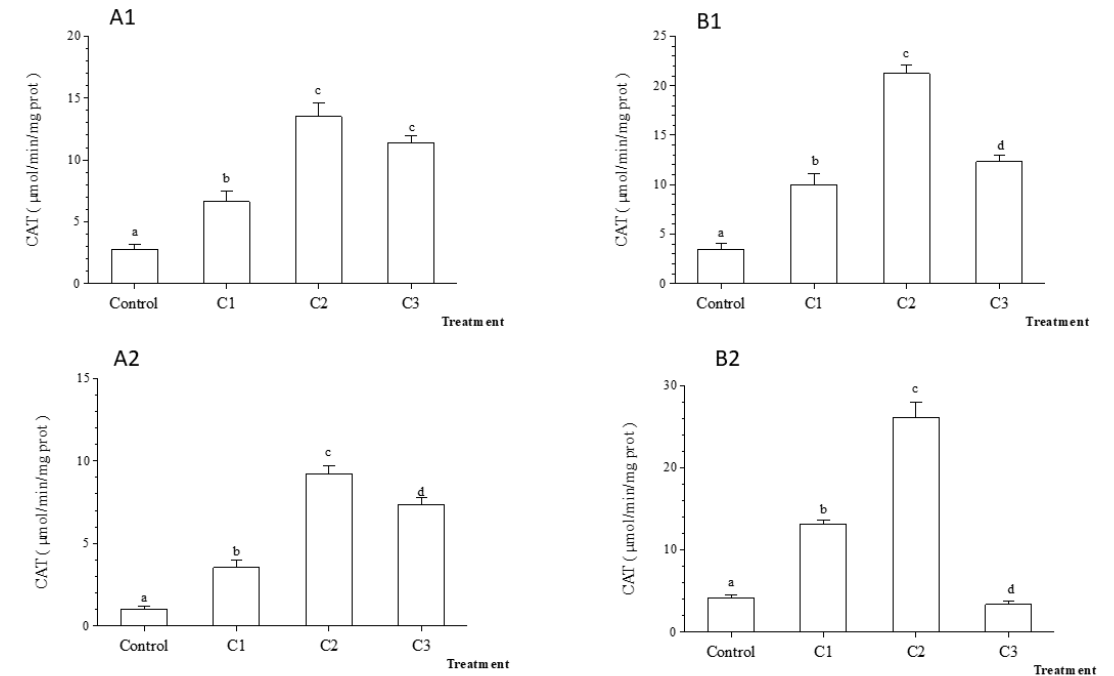
Figure 7. Average catalase (CAT) activity ( ± standard deviation) in the freshwater mussel Unio ravoiseri after exposure to Control and three concentrations of Titanium dioxide nanoparticles during 48 h and 7 days in gills, respectively ( A1 ) and ( A2 ) and in digestive gland ( B1 ) and ( B2 ). Bars represent the group means ± SE; a, b, c, d: data not sharing a common letter are significantly different using Tukey’s HSD test ( p < 0.05).